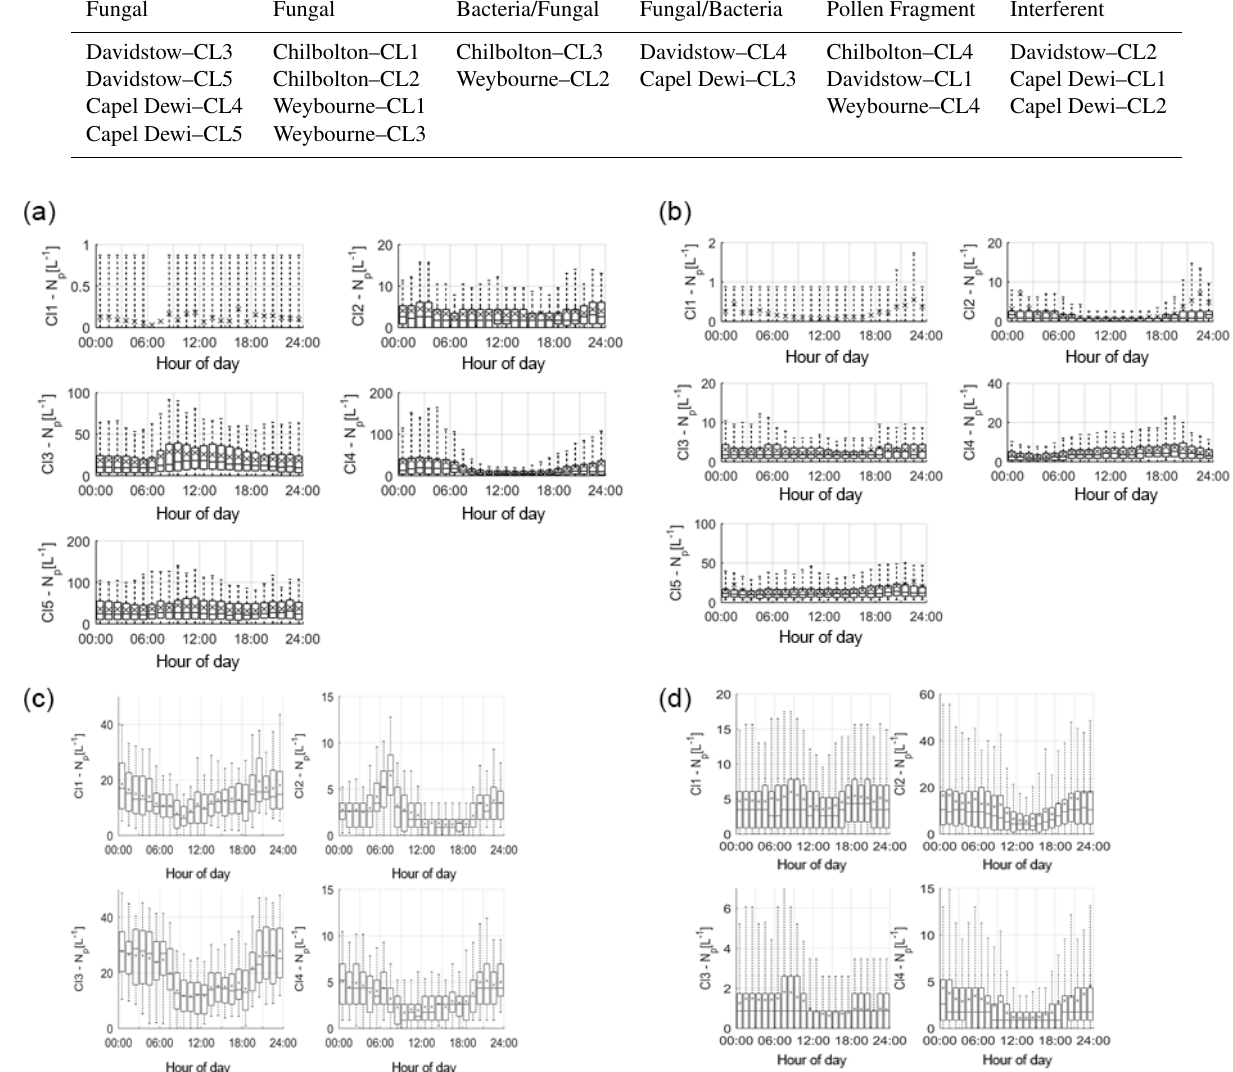
Figure 3. Average cluster diurnal variation at each site ( a – Davidstow, b – Capel Dewi, c – Weybourne, and d – Chilbolton).